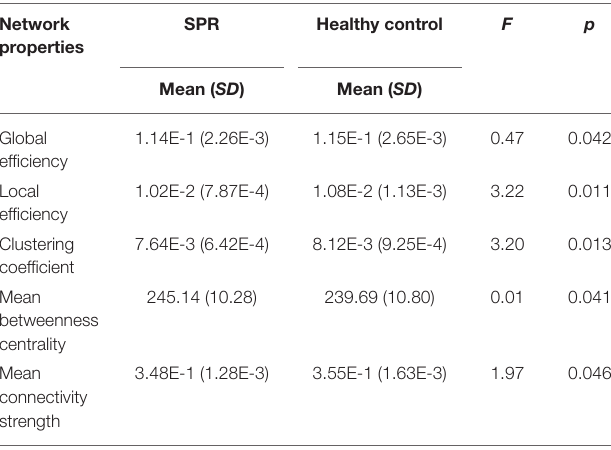
TABLE 2 | Global network properties of schizophrenia (SPR) patients and healthy control subjects. Network